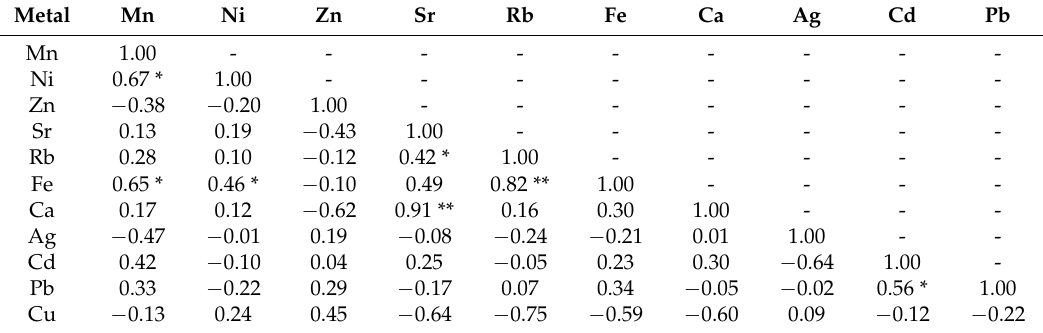
Table 4. Pearson correlation coefficient ( n = 35; ** p value < 0.01; * p value <